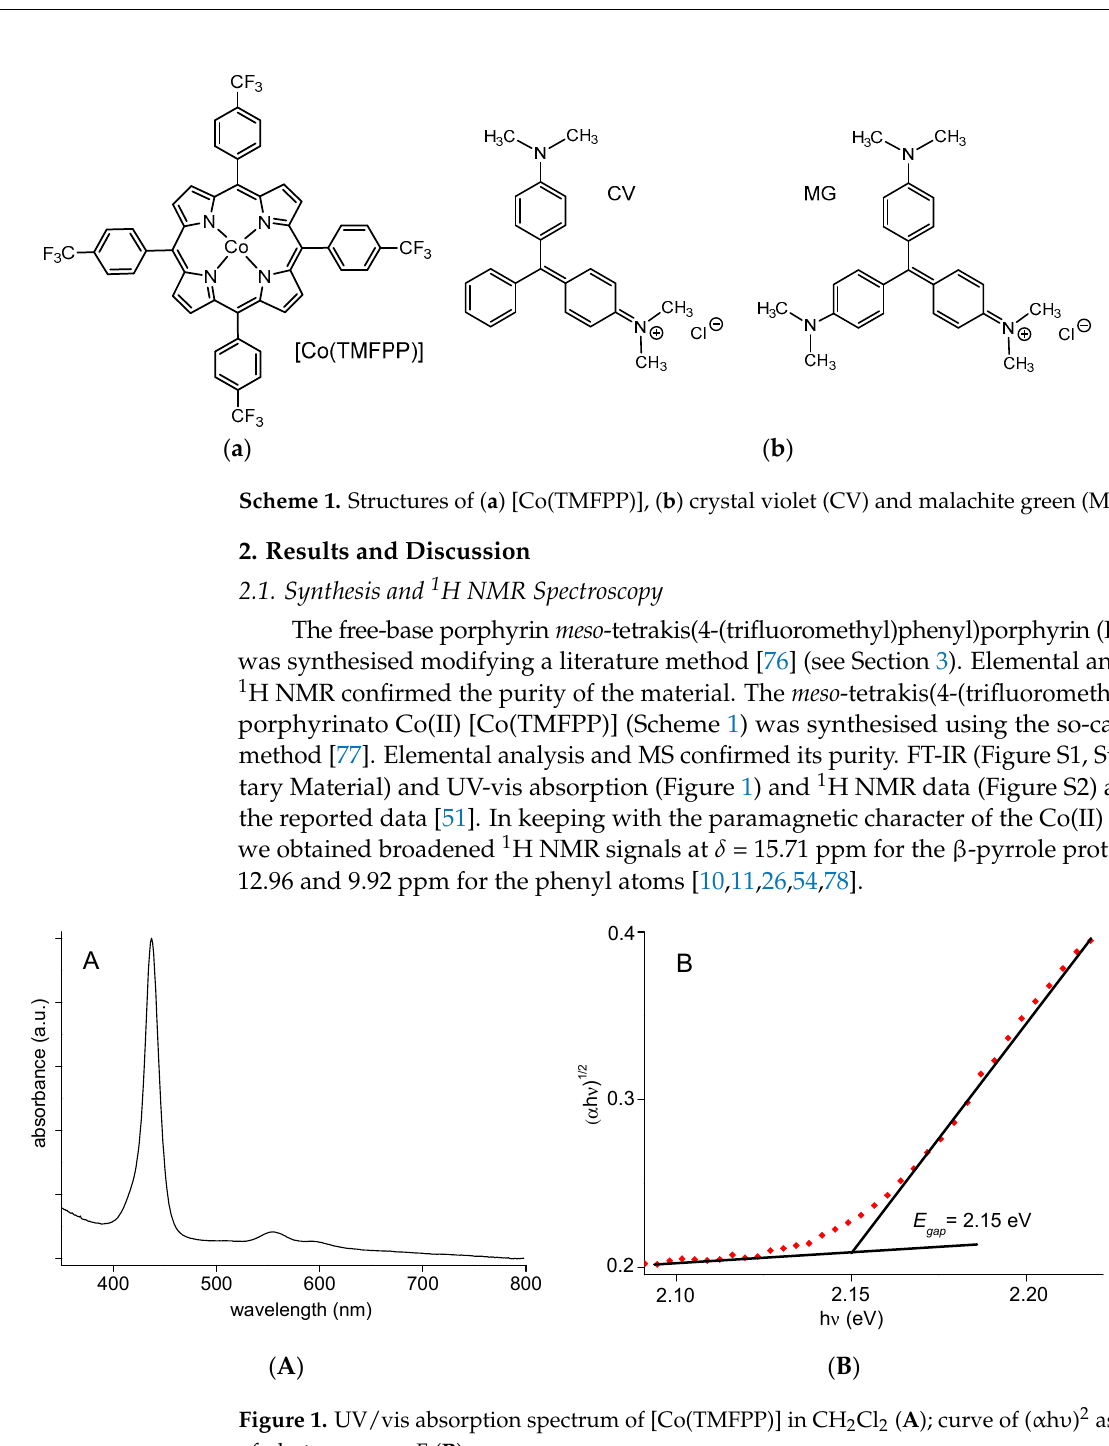
Figure 1. UV/vis absorption spectrum of [Co(TMFPP)] in CH 2 Cl 2 (A); curve of ( α h υ ) 2 as a function of photon energy E (B).